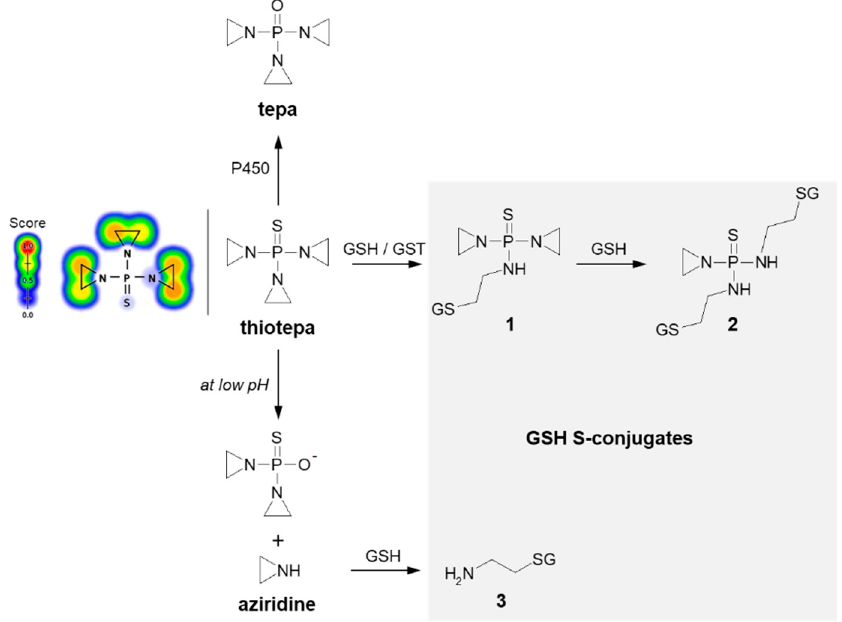
Figure 8. Scheme of thiotepa activation and drug reaction with GSH [89]. Possible GSH S-conjugates: 1 : monoglutathionyl thiotepa, 2 : diglutathionyl thiotepa, 3 : 2-aminoethyl glutathione. P450 = cytochrome P450. Predicted bioactive sites of GSH conjugation for anticancer drug were obtained by XenoSite Reactivity Predictor available at https://swami.wustl.edu/xenosite/p/reactivity (accessed on 18 May 2022).